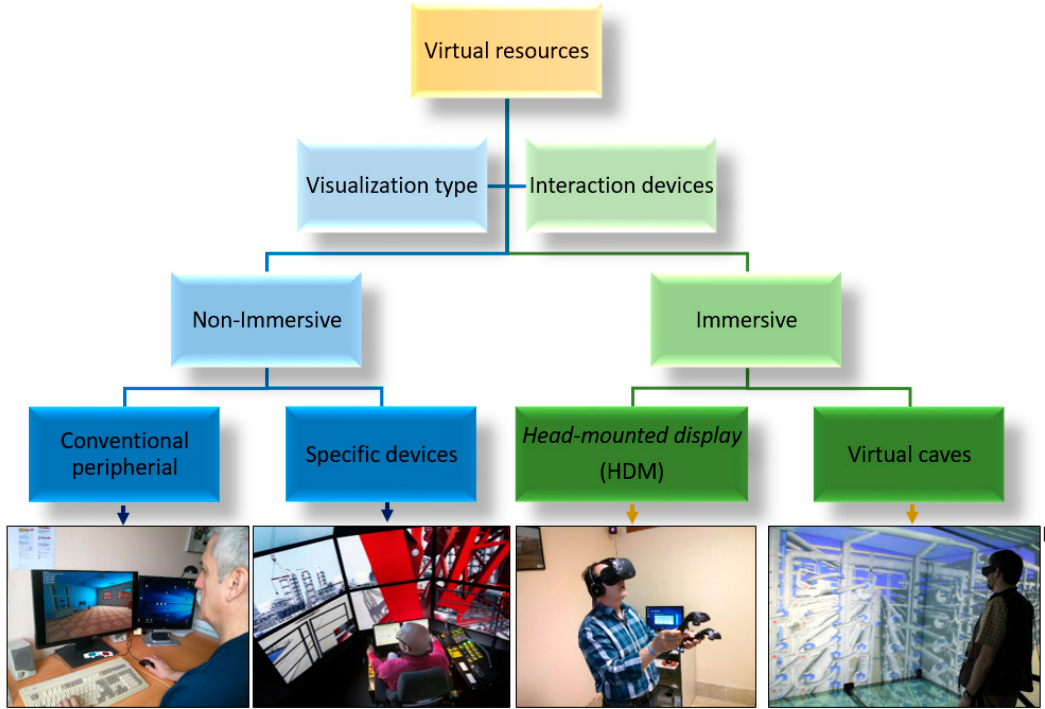
Figure 2. Classification of VR resources according to visualization and interaction devices. Specific device images are from the construction company Mammoet (www.mammoet.com). Virtual cave image is from the Technical University of Zvolen, Slovakia (http://etools.tuzvo.sk/cave).